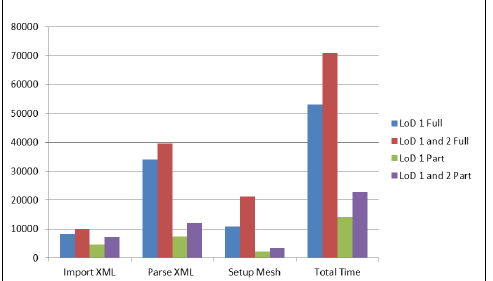
Figure 7: Rendering Results for All Datasets